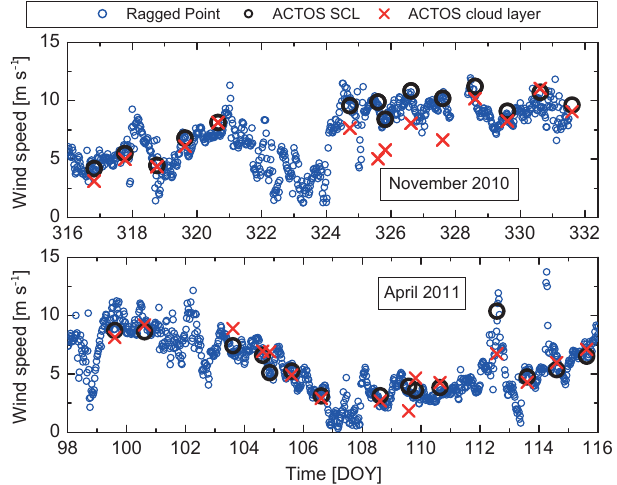
Figure 6. Wind speed as measured at Ragged Point (30min aver- age) and on ACTOS (averaged for each research